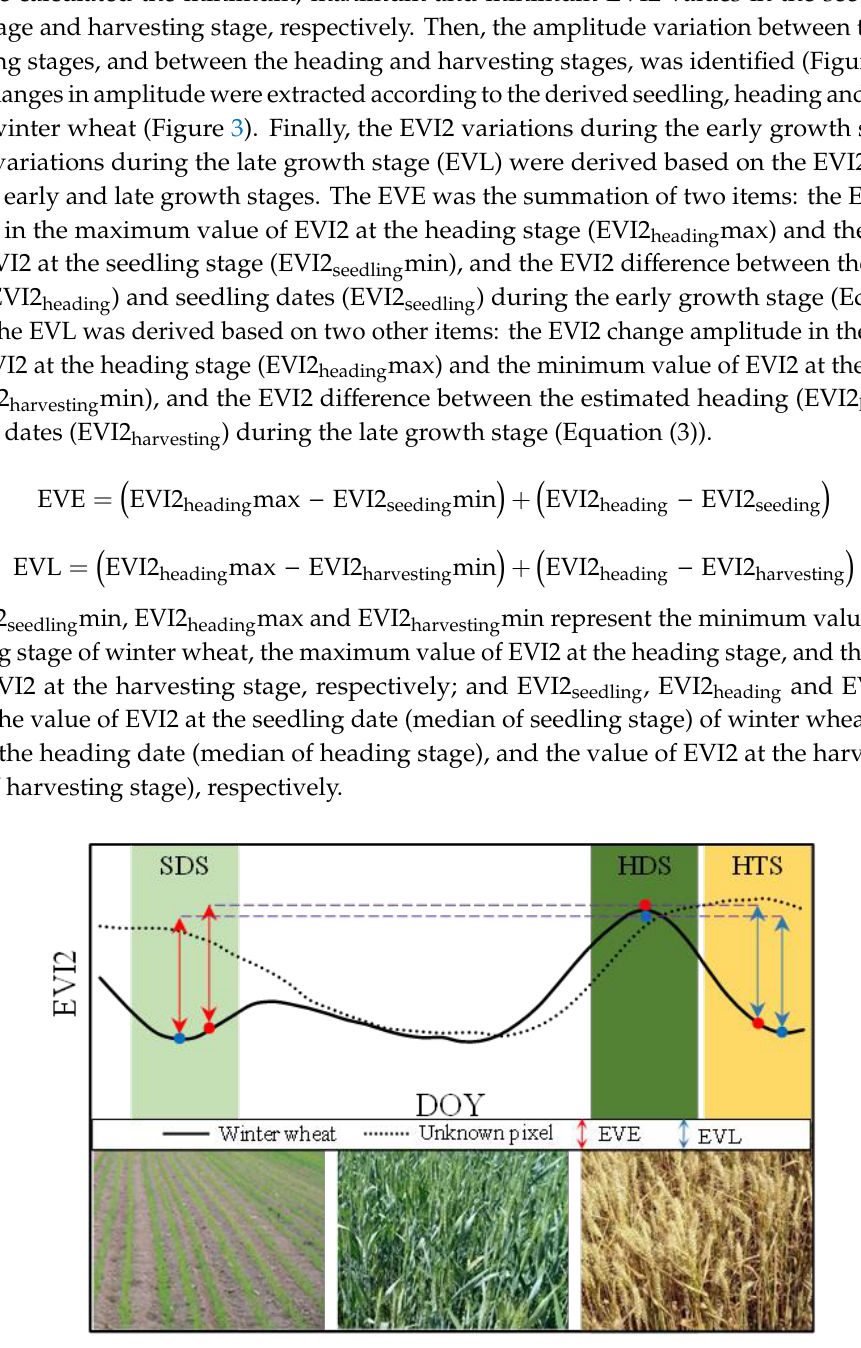
Figure 3. Schematic of phenological index extraction of winter wheat. Black solid line represents winter wheat, black dotted line represents unknown pixels, red arrow represents the EVE, blue arrow represents the EVL, SDS (light green shaded rectangular belt) represents the seedling stage, HDS (green shaded rectangular belt) represents the heading stage, and HTS (yellow shaded rectangular belt) represents the harvesting stage.